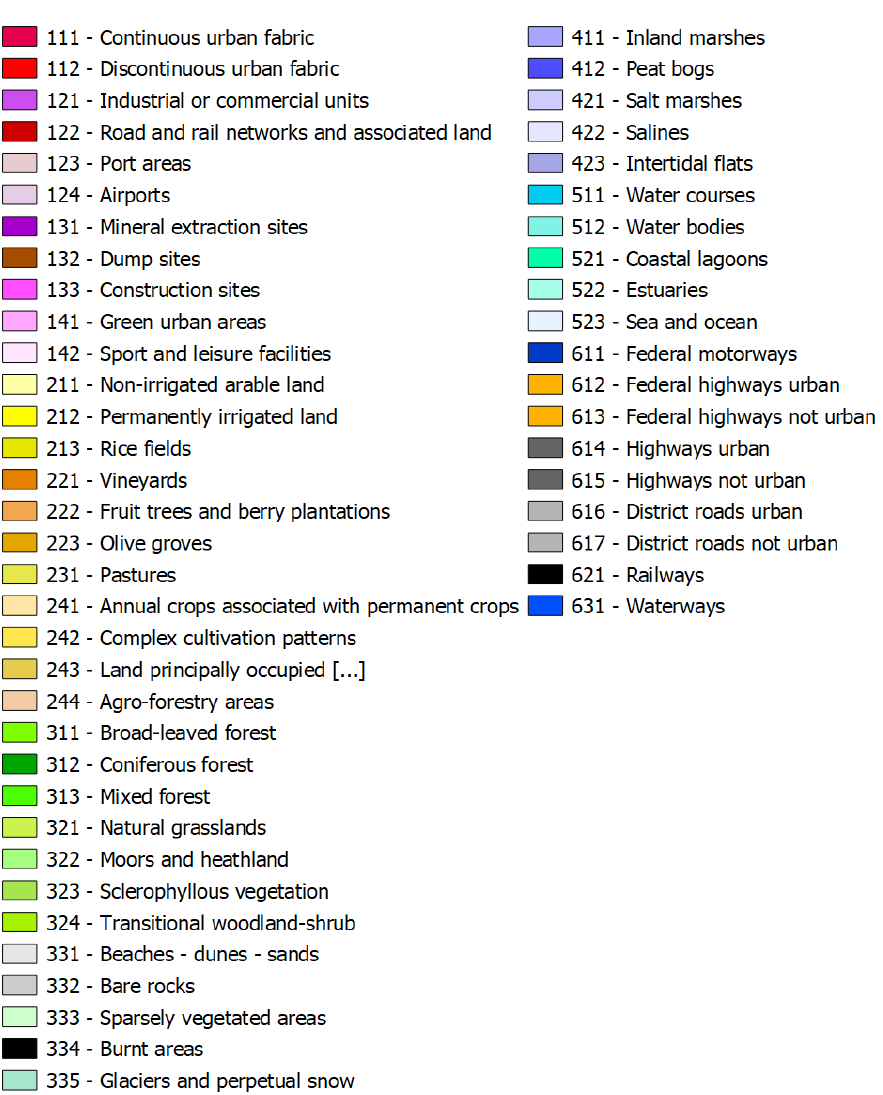
Figure A1. Colour, number, and name of all level 3 CORINE land cover classes (classes 611–631 were manually